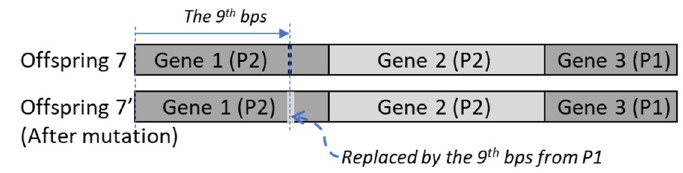
Figure 2. The illustration of the crossover and mutation operator.